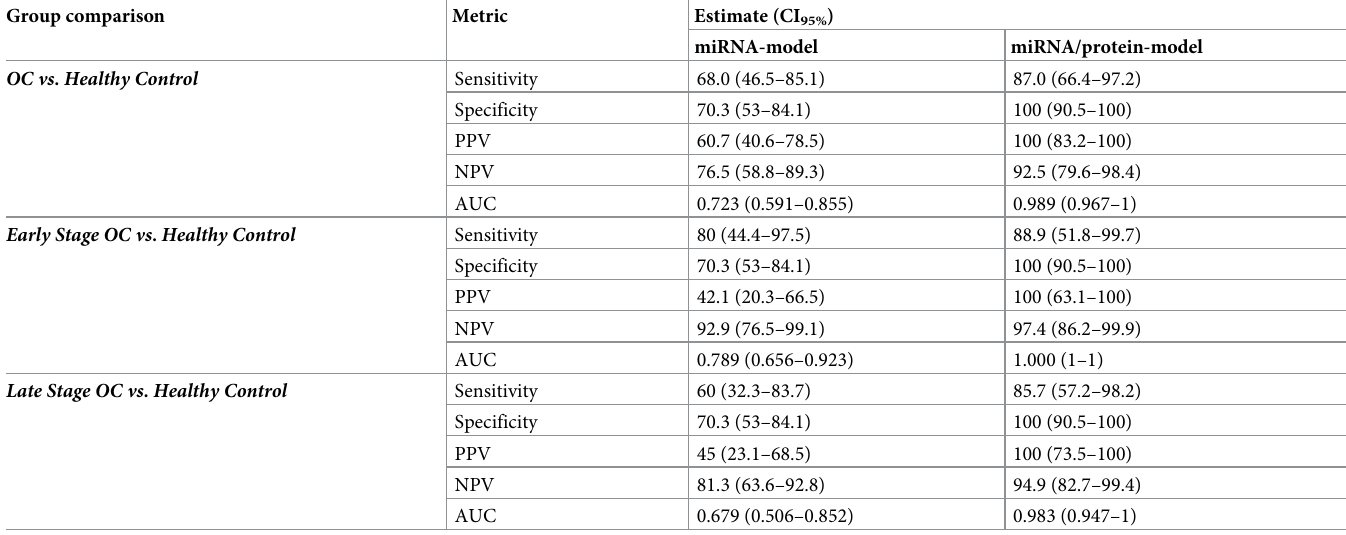
Table 4. Classification performance of the miRNA and miRNA/protein-based models in distinguishing cancer from control patients in the Validation set. Group